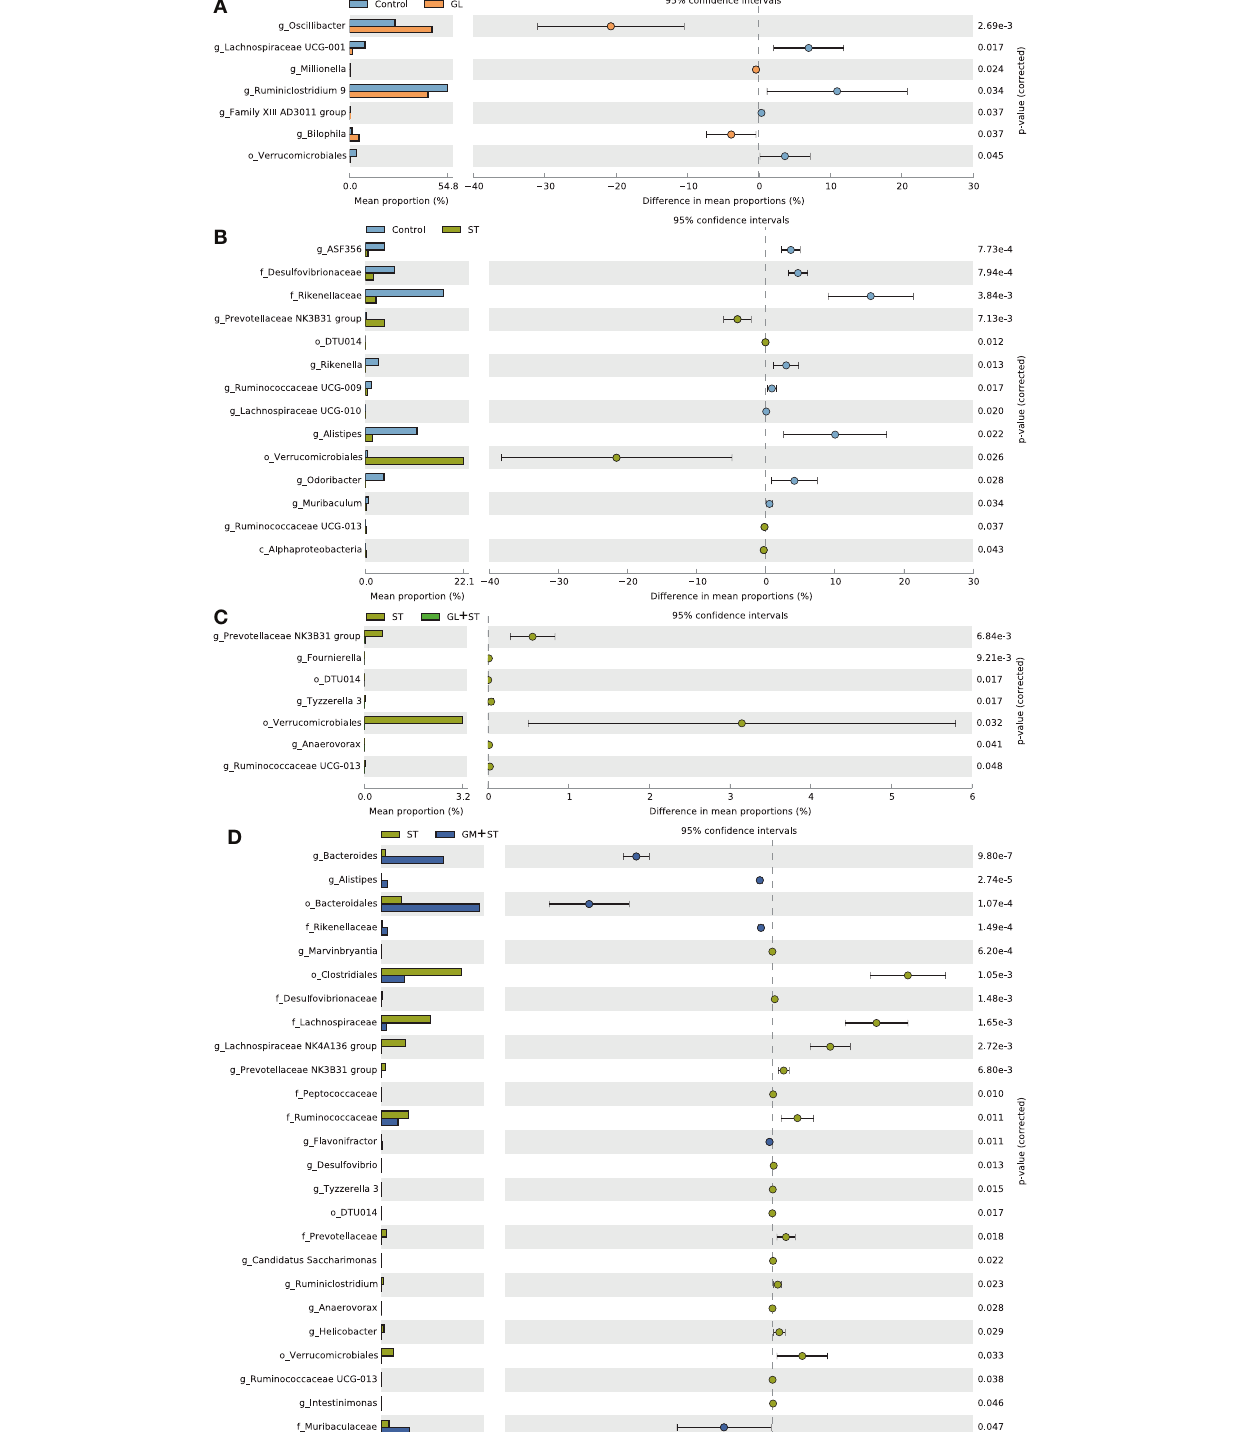
Frontiers in Veterinary Science |